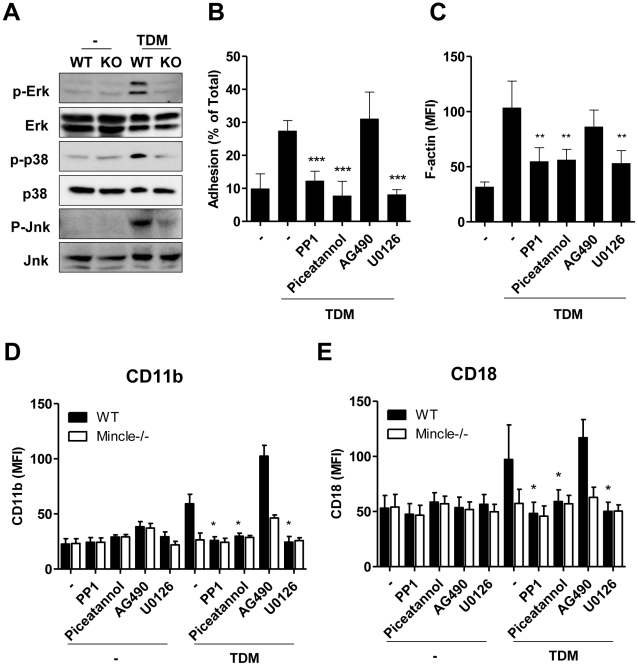
Activation of Syk and MAP kinase during TDM-mediated neutrophil adhesion.(A) Levels of phosphorylated Erk, p38, and Jnk in wild-type (WT) and Mincle−/− (KO) bone marrow (BM) neutrophils 30 min after TNFα (Con) and TNFα/trehalose dimycolate (TDM) stimulation as determined by immunoblot analysis. (B–C) Neutrophil adherence (B) and F-actin polymerization (C) were measured in C57BL/6 BM neutrophils stimulated with TDM in the presence of PP1 (5 µM), Piceatannol (40 µM), AG490 (25 µM), or U0126 (10 µM). Statistical significance is shown relative to TDM-treated neutrophils. **p<0.01, and ***p<0.001 (D–E) Surface expression of CD11b (B) and CD18 (C) was measured by flow cytometry in WT and Mincle−/− BM neutrophils stimulated with TDM for 18 h in the presence of specific inhibitors. Statistical significance is shown relative to TDM-treated WT neutrophils. *p<0.05. Data are expressed as means ± SEM from three independent experiments.